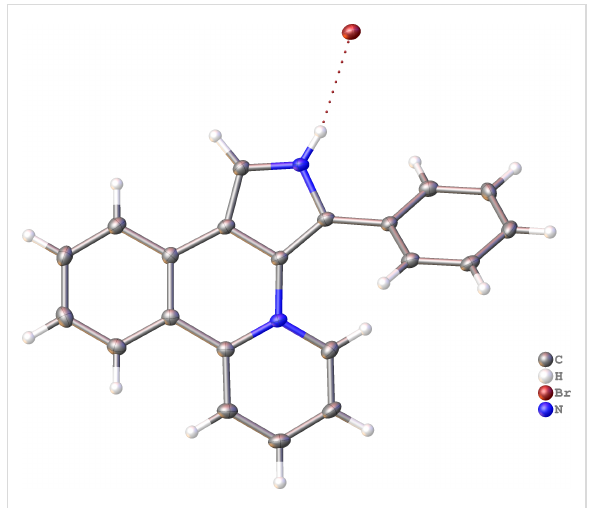
Figure 1: Molecular structure of compound 3a , displacement parame- ters are drawn at 50%.